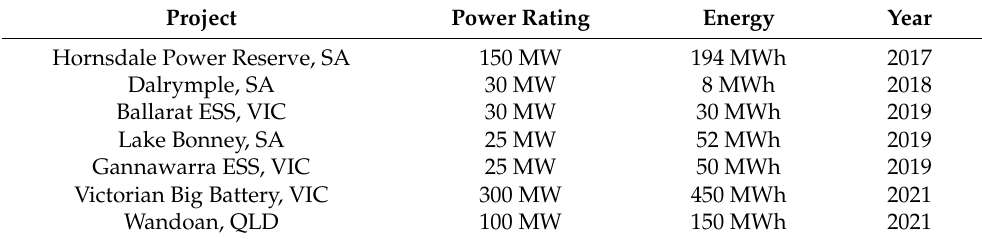
Table 5. Operational battery energy storage systems in Australia [11].